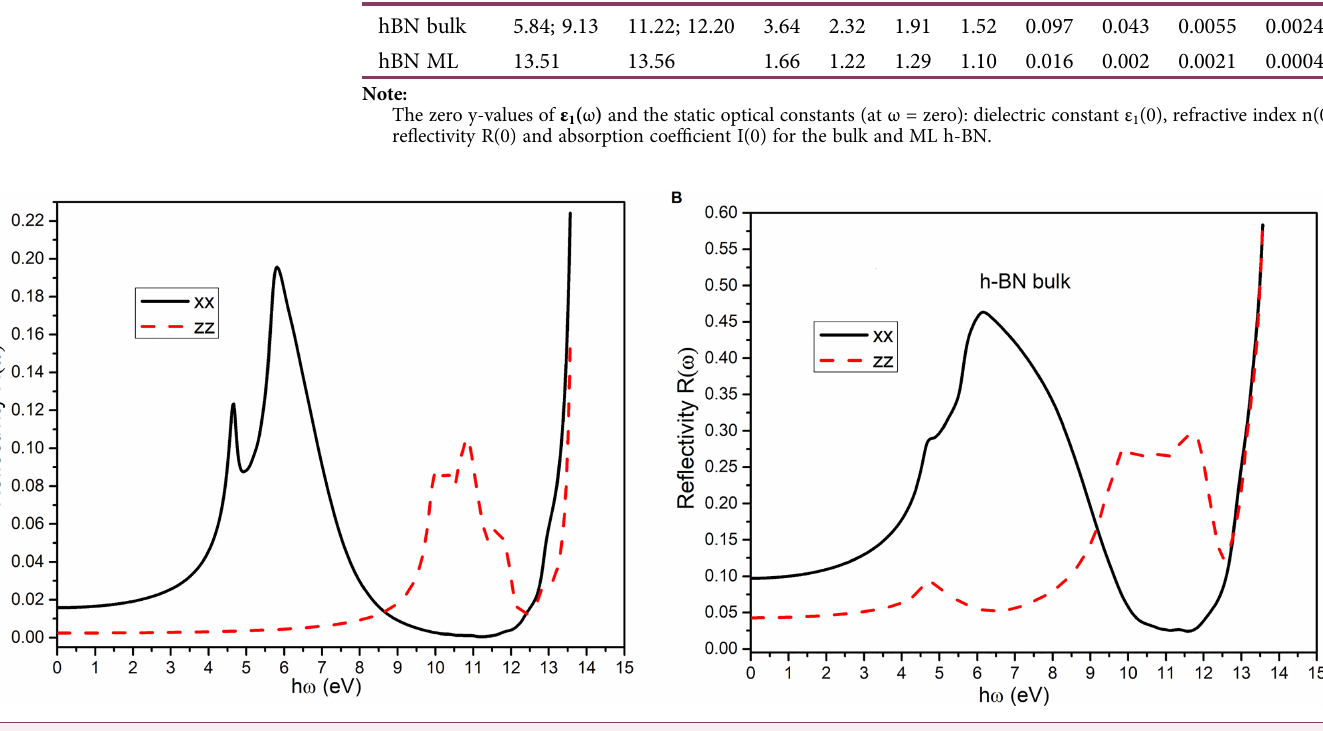
Figure 5 The re fl ectivity of ML h-BN. (A) The re fl ectivity plots for ML h-BN in the xx and zz directions. (B) The re fl ectivity plots for bulk h-BN in the xx and zz directions.